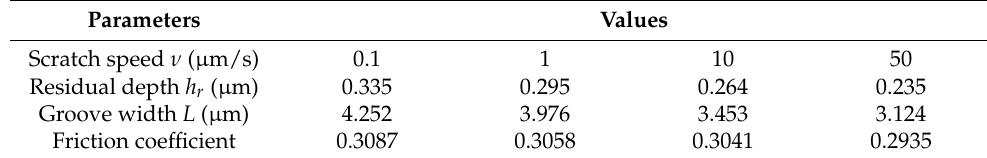
Table 2. Residual depth, groove width, and friction coefficient of scratches at different speeds Parameters Values Scratch speed ν ( µ m/s) 0.1 Residual depth h r ( µ